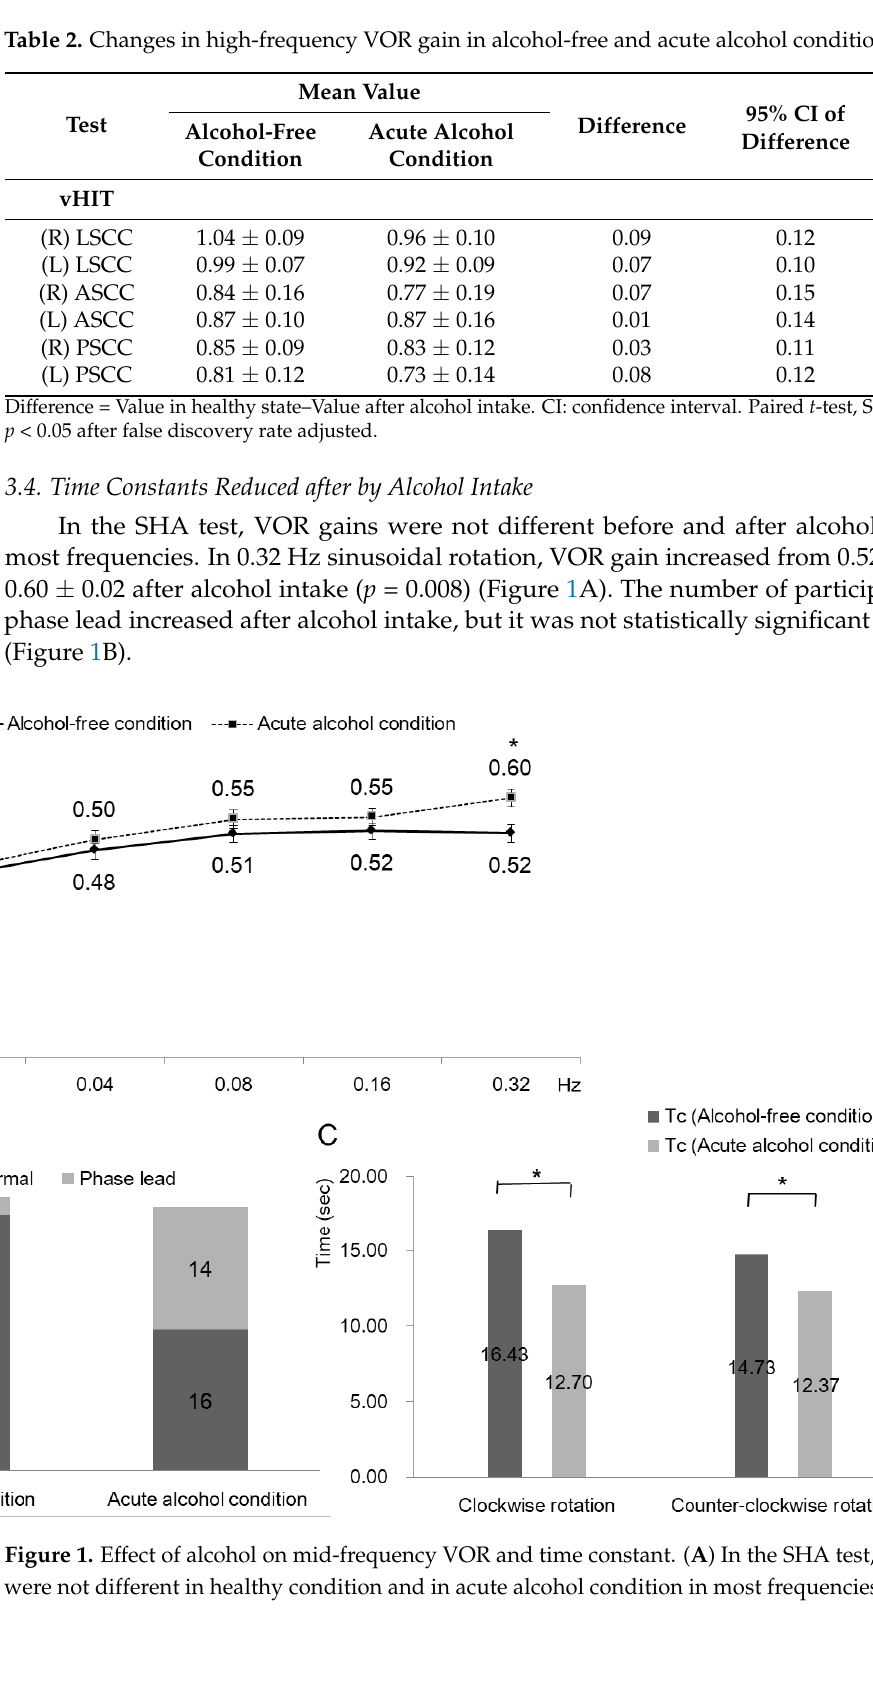
Table 2. Changes in high-frequency VOR gain in alcohol-free and acute alcohol conditions. Test